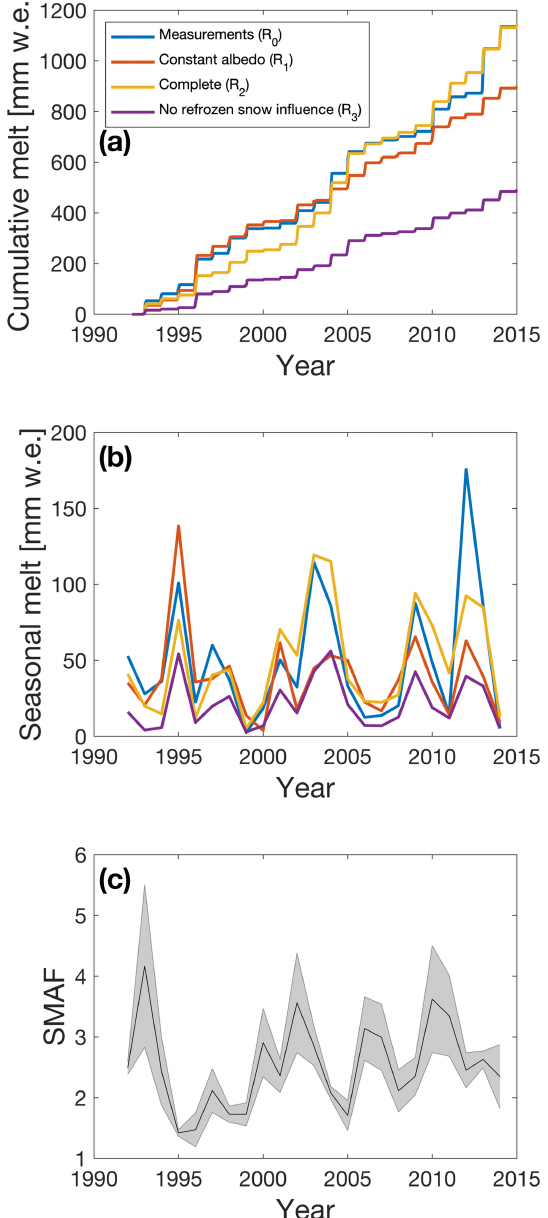
Figure 10. (a) Time series of the modelled cumulative amount of melt for the run with measured albedo ( R 0 , blue), a constant albedo of 0.84 ( R 1 , red), a run in which refrozen snow impacts snow grain size ( R 2 , yellow) and a run in which snow grain size is not influ- enced by refrozen snow ( R 3 , purple). (b) Same as panel (a) but for seasonal amount of melt. (c) Ratio of modelled surface melt be- tween yellow and purple lines in panels (a) and (b) (runs R 2 and R 3 respectively). The grey area indicates the uncertainty coming from the uncertainty in the determination of τ (Fig. 2b), ± 5Wm − 2 measurement uncertainty in SW ↑ and the inclusion of shortwave radiation